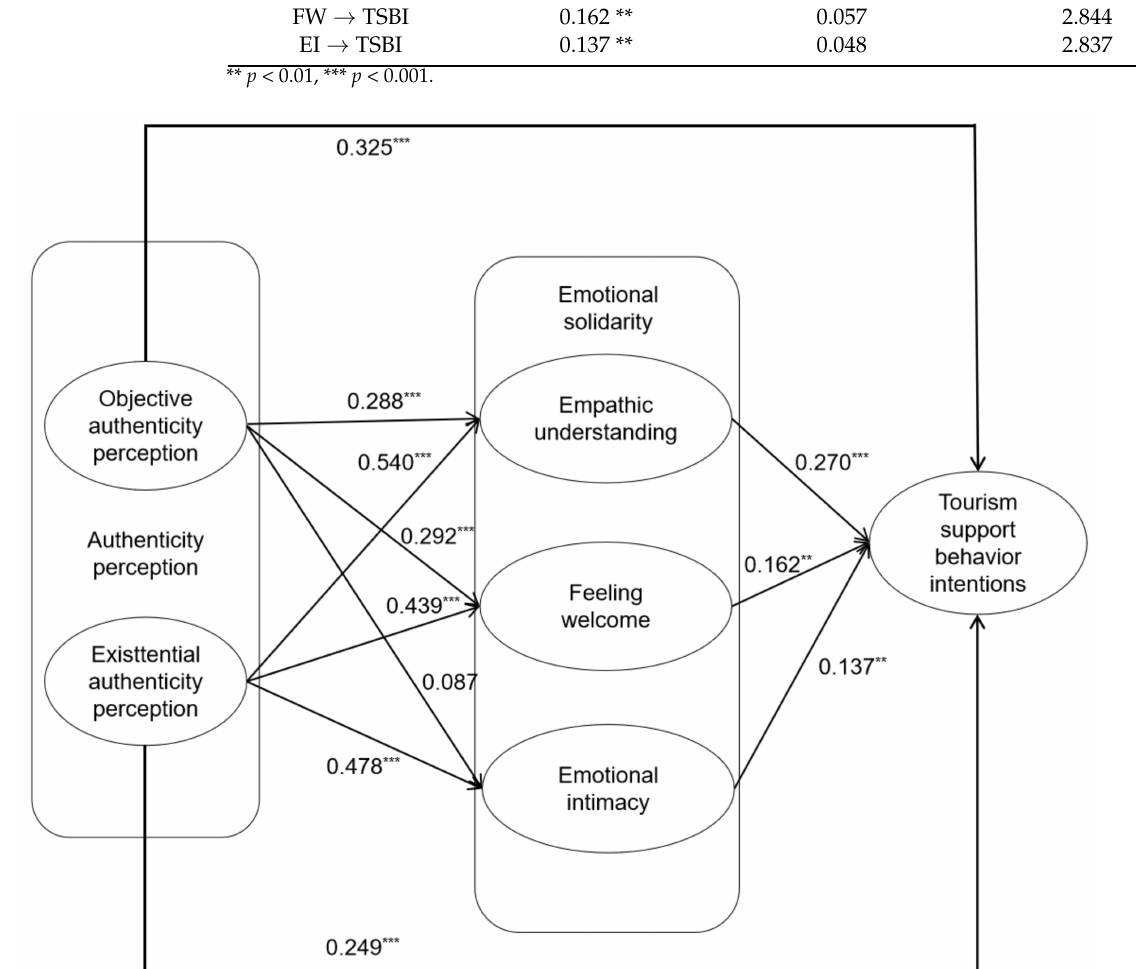
Figure 2. Results of the hypotheses test. ** p < 0.01, *** p <